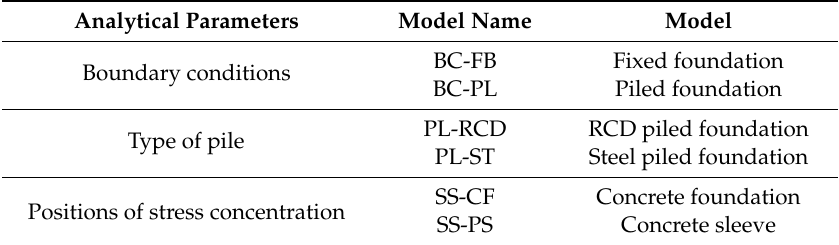
Table 6. Definition of structural models.